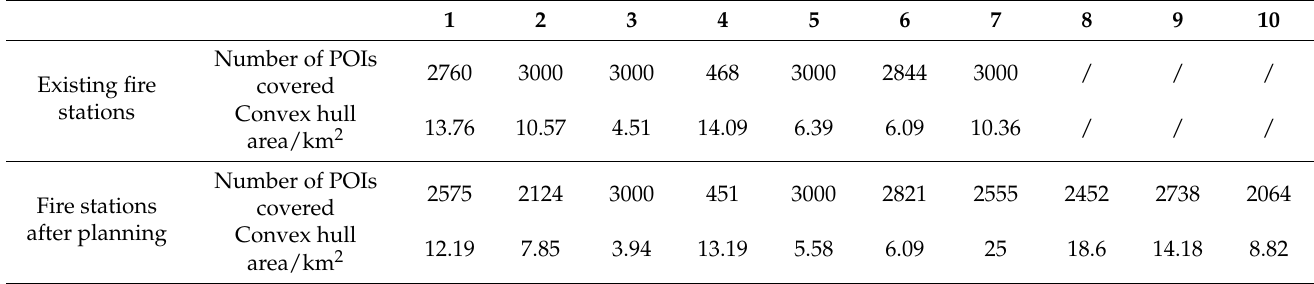
Figure 8. Service areas of fire stations. ( a ) Existing fire stations. ( b ) Fire stations after planning. Table 5. POI coverage and the convex hull area of each fire station before and after planning.